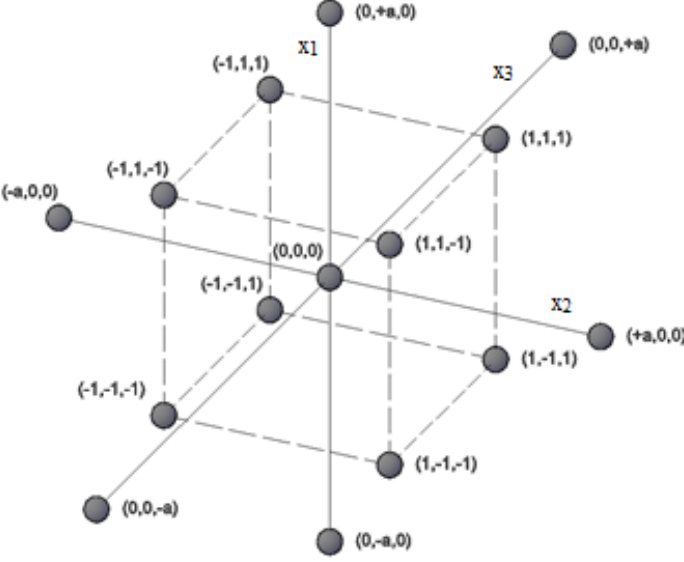
Figure 1. Experimental points given by the central composition design.